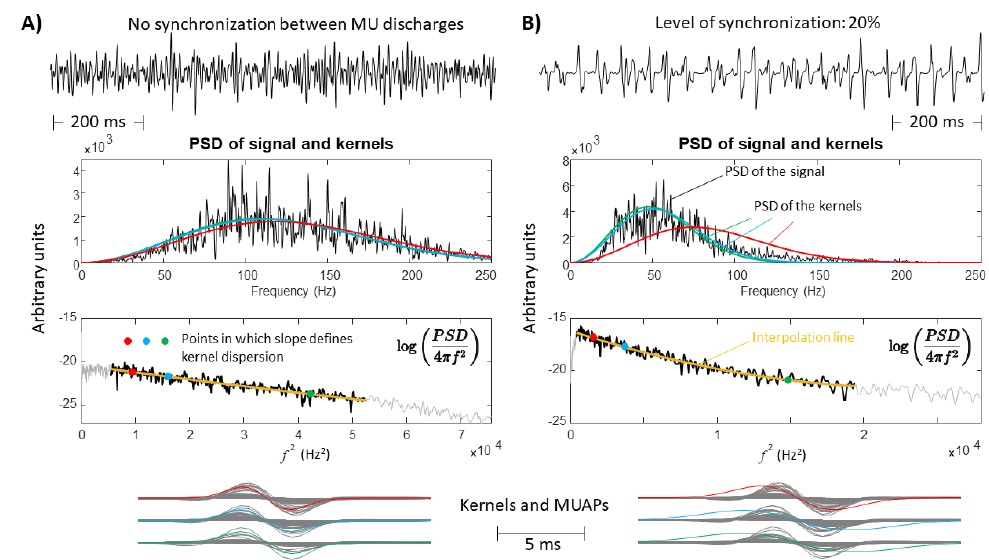
Figure 2. Estimation of three kernels, in the cases of ( A ) no synchronization between MU discharges or ( B ) high synchronization (signal with one IZ; 80% MVC, fat layer thickness of 3 mm, mean CV of 4 m/s, CoV of ISI 10%, and maximum FR 40 Hz). From top to bottom, the following panels are shown: the signal; its PSD (black) and the ones of the three estimated kernels (in red, blue, and green, keeping the same colours for indicating the same kernels in the following panels); the function of the PSD used to estimate the kernels (in black is the data in the range of interest, in gray is the part out of this range; the interpolation line is in yellow; the points used to estimate the kernels are coloured); and the kernels (with their colour) are superimposed to the MUAPs (in gray) whose CWF best correlates with its deconvolution